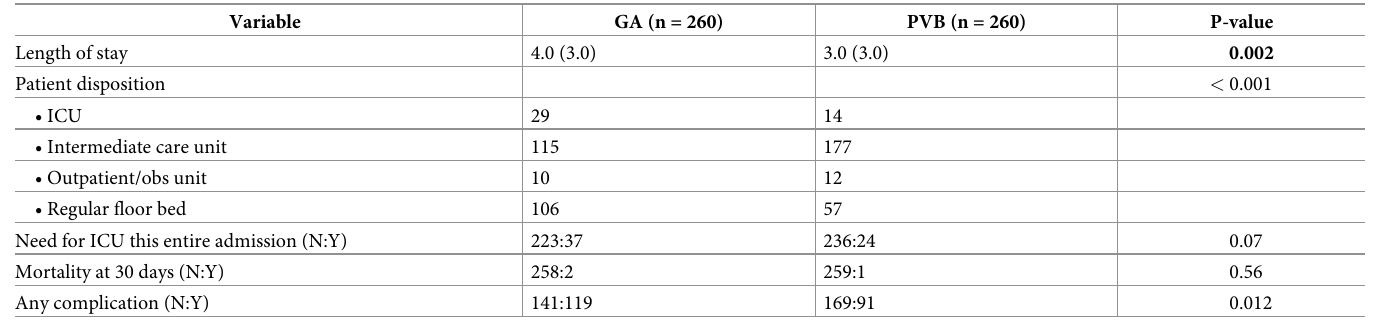
Table 4. Other secondary outcomes.